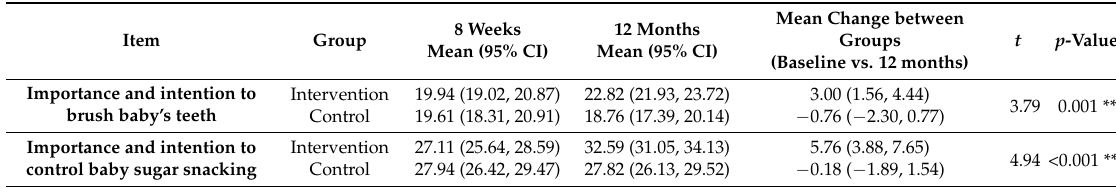
Table 4. Comparison of changes in mean scores of maternal oral health knowledge and attitudinal scales by time between intervention and control groups.